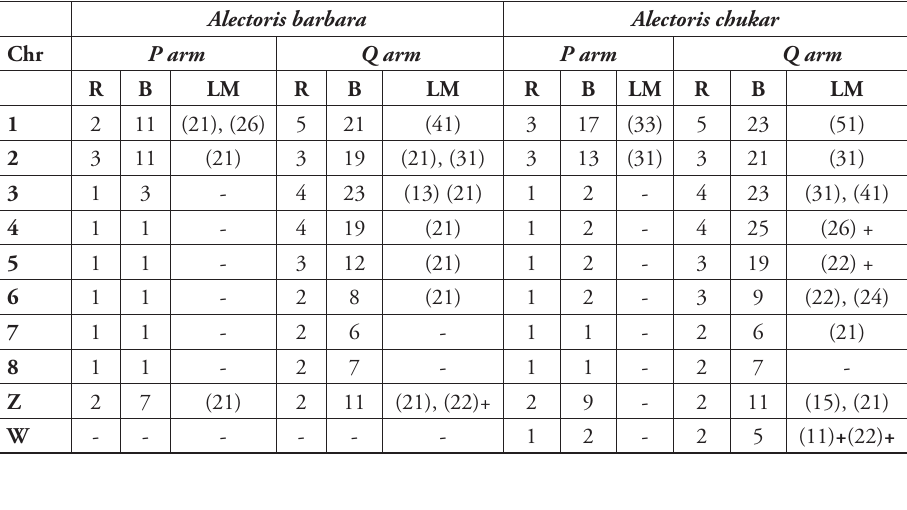
Table 2. Values summarized from partial ideograms of A. barbara and A. chukar described in GTG bands. Chr: chromosome, p: short arm, q: long arm, R: region, B: bands, LM: Landmark (all positions show negative landmarks except when (+) is added), empty boxes indicate that there is no particular